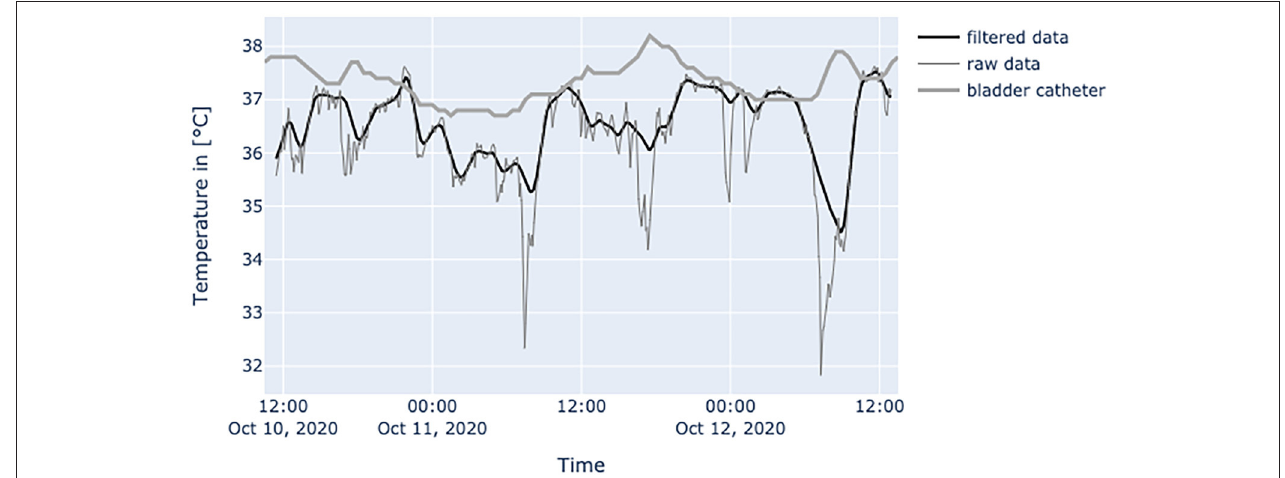
FIGURE 9 | Diagram shows values of an obese (BMI: 34.6 kg/m ² ) patient at the age of 52 years, in relatively good condition, often fully exposing the skin area around the patch to environment. In a patient with this amount of disturbances only the peak patch values should be used. Errors can be easily interpreted by the spikes downwards in raw data.